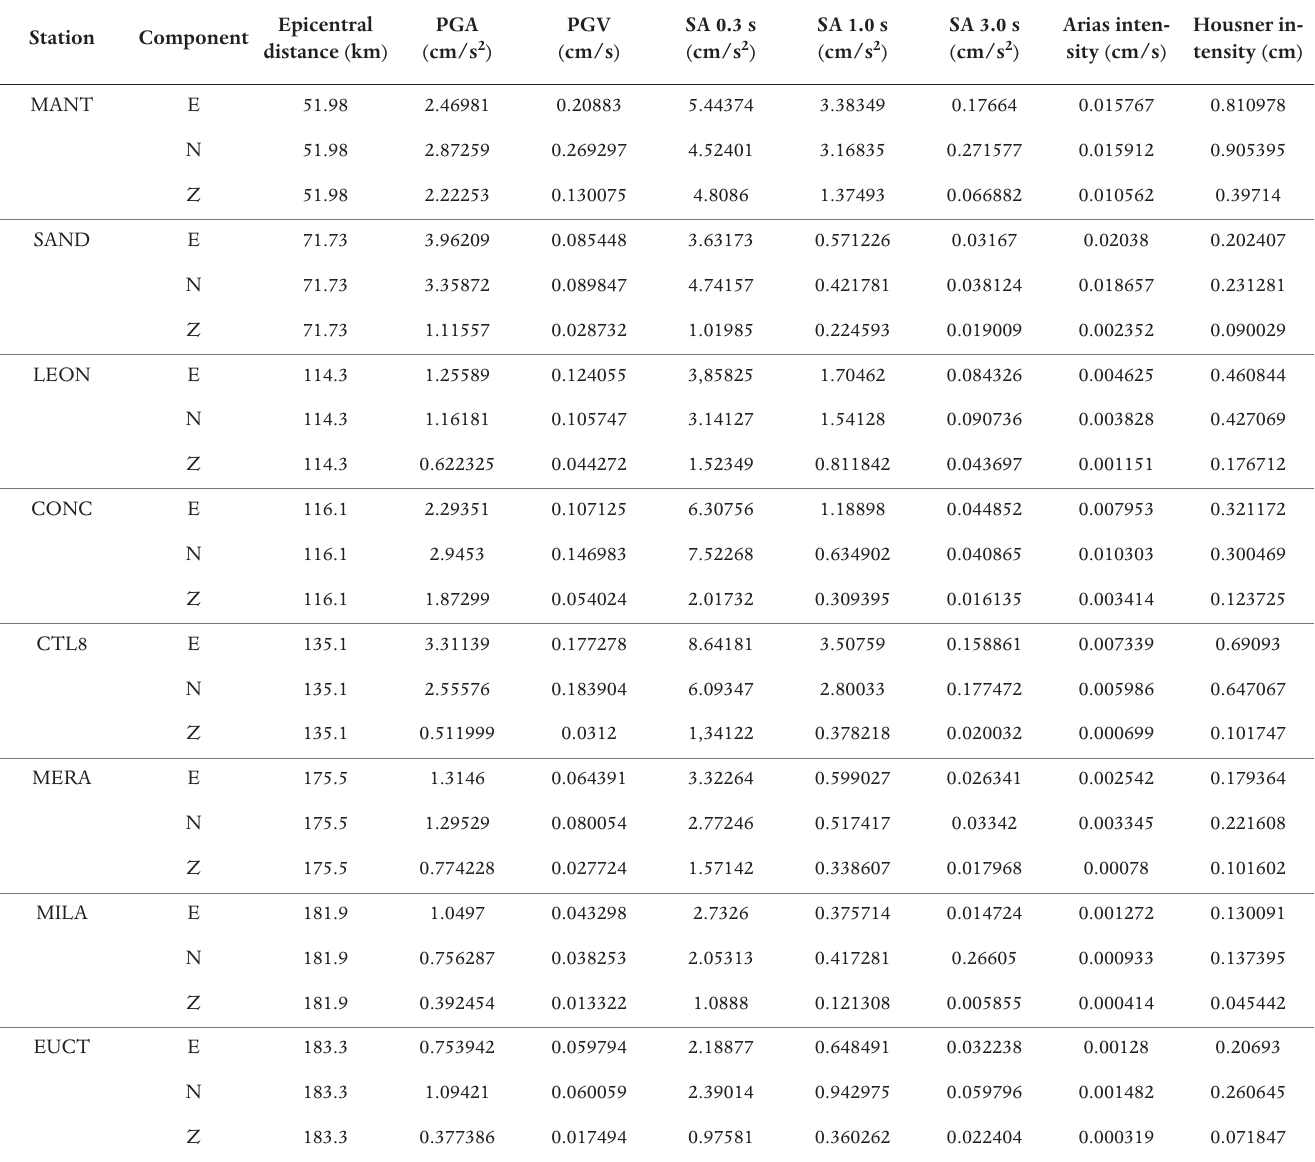
Table 2. Ground-motion parameters calculated from the collected